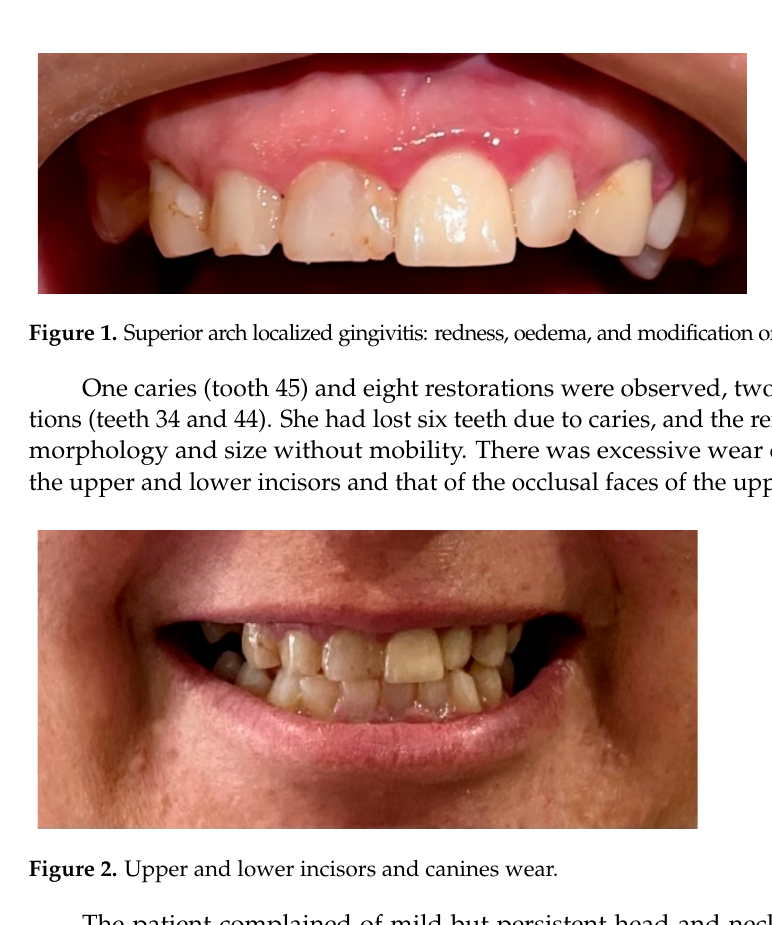
Figure 2. Upper and lower incisors and canines wear.